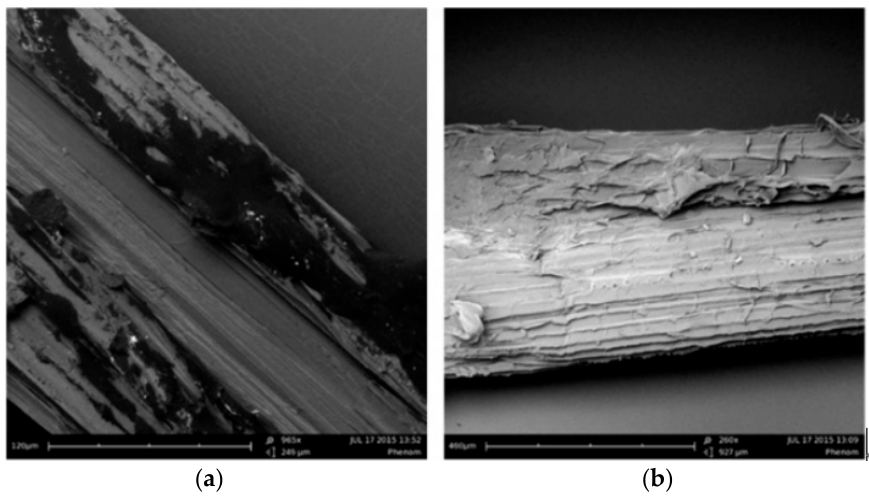
Figure 1. SEM pictures of banana fibers: ( a ) fibers treated with Biopectinase M01; ( b ) fibers treated with Biopectinase K.